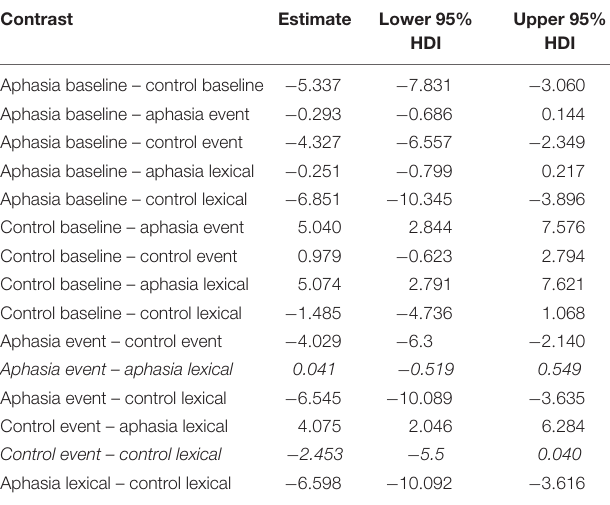
TABLE 7 | Model 2 naming response time pairwise comparisons.